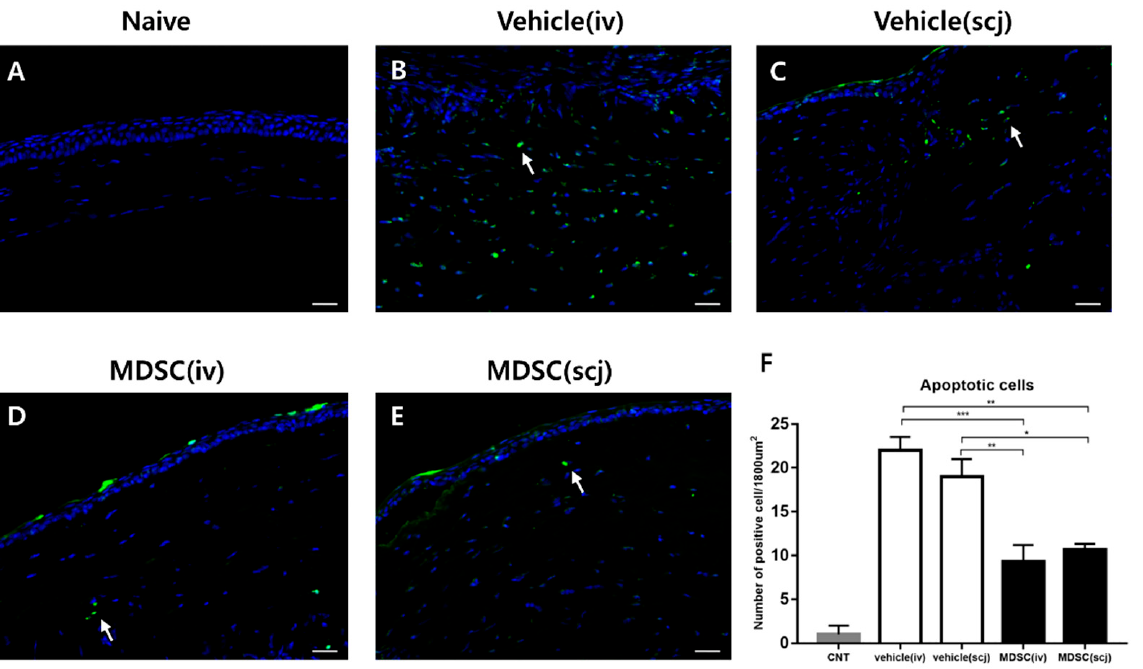
Figure 4. Assessment of cellular apoptosis in the corneal graft 6 weeks after the operation. Repre- sentative terminal deoxynucleotidyl transferase dUTP nick end labeling (TUNEL; green; white ar- row) assay images (20× magnification, scale bar = 50 μ m) of the corneal graft of each group; non-transplanted naive cornea ( A ), PBSiv ( B ), PBSscj ( C ), MDSCiv ( D ), and MDSCscj ( E ). ( F ) Quantitative analysis graph of TUNEL-positive apoptotic cells (green). MDSC-treated groups